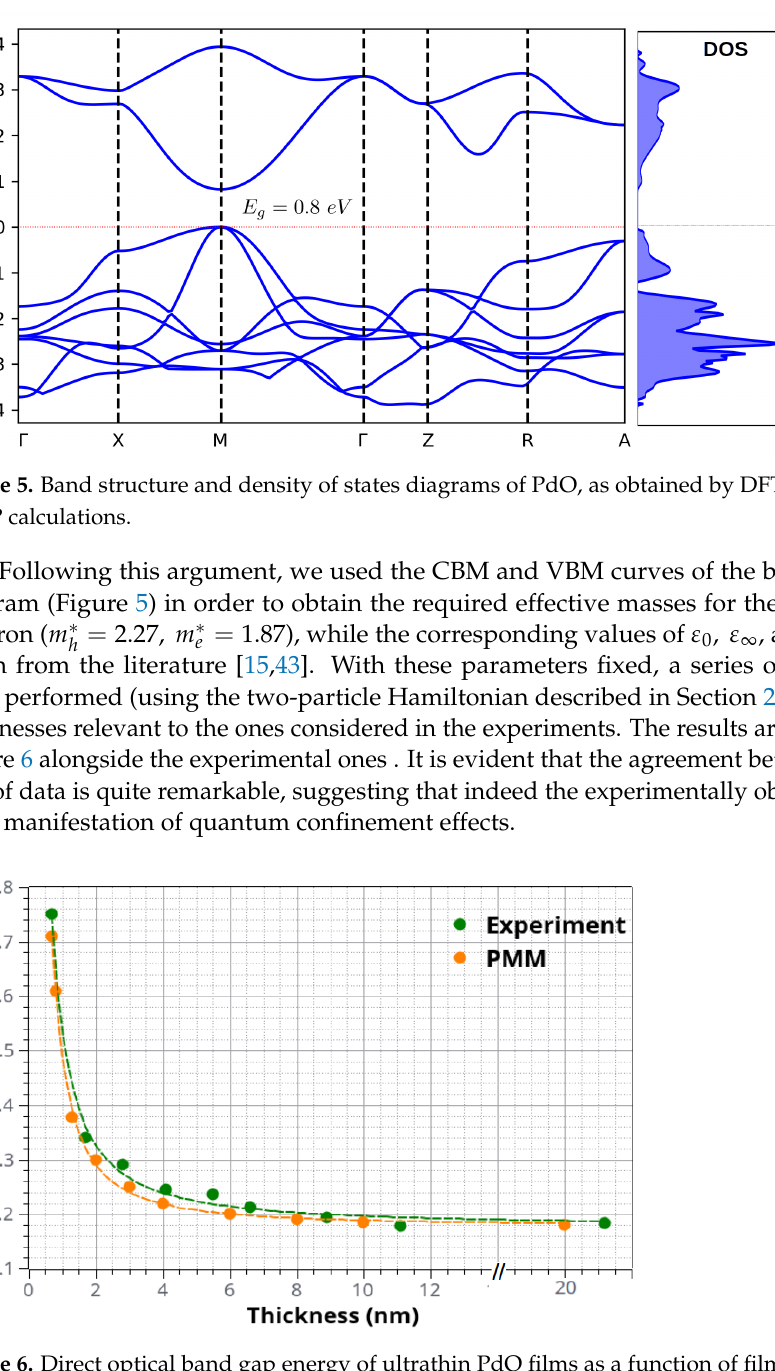
Figure 6. Direct optical band gap energy of ultrathin PdO films as a function of film thickness t by experiment and theory. The typical error bar is ± 2 meV except in the case of the thinnest sample where it is about 50 times larger (see the two straight lines for this sample in the Tauc plots of Figure